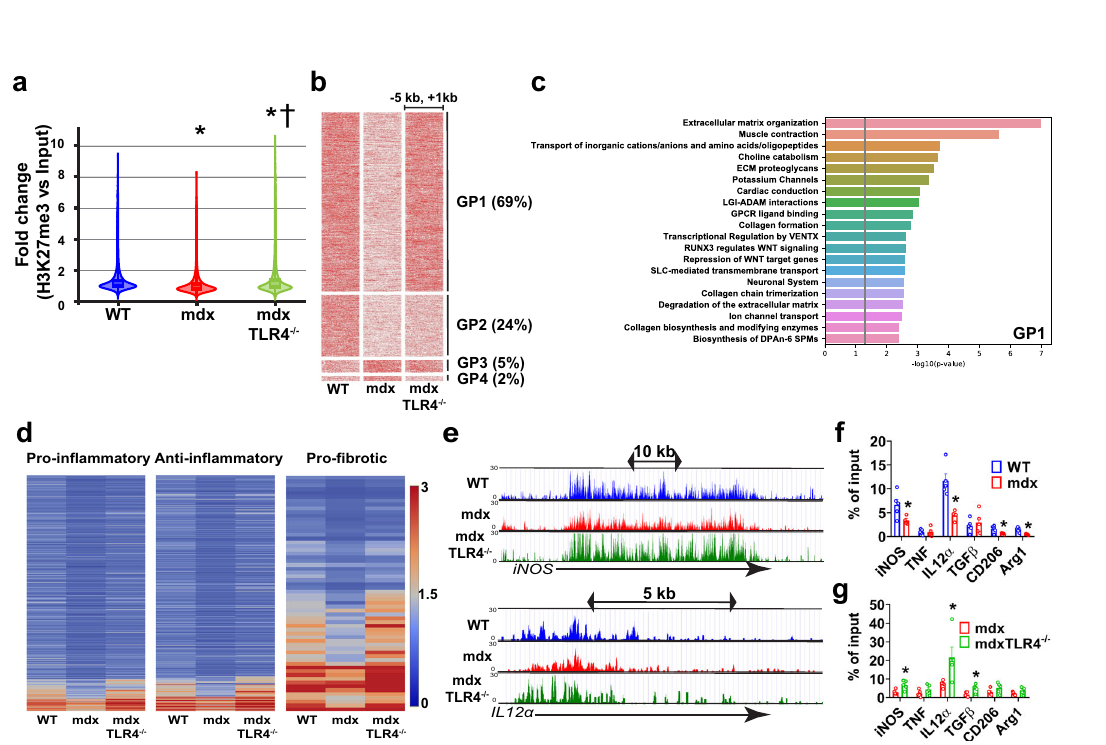
Fig. 6 Dynamic regulation of H3K27me3 is present in mdx BMDM and mediated by TLR4. ChIP sequencing was performed in WT, mdx and mdxTLR4 – / – BMDM: a Violin plots representing normalized intensity fold-change (H3K27me3 vs. Input) in the – 5 kb to + 1 kb neighboring genomic region around all genes across the whole genome; * P < 0.0001 compared to WT BMDM and † P < 0.0001 compared to mdx group (two-sided Mann – Whitney U -test). b Heatmaps showing, in order of frequency (indicated by the percentages in parentheses), the different Gene-based Patterns (GP1-4) of the normalized H3K27me3 read intensity (variable units proportional to red color intensity) within the nearby region [ – 5 kb to + 1 kb] of the gene body for WT, mdx and mdxTLR4 – / – BMDM. c Pathway enrichment analysis (Reactome database) for genes showing the predominant GP1 con fi guration (Supplementary Data